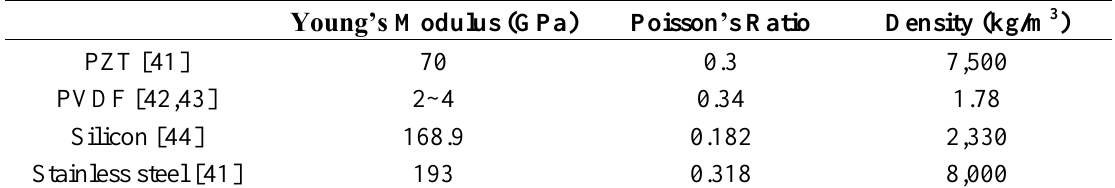
Table 1. Material properties of PZT, PVDF, silicon and stainless